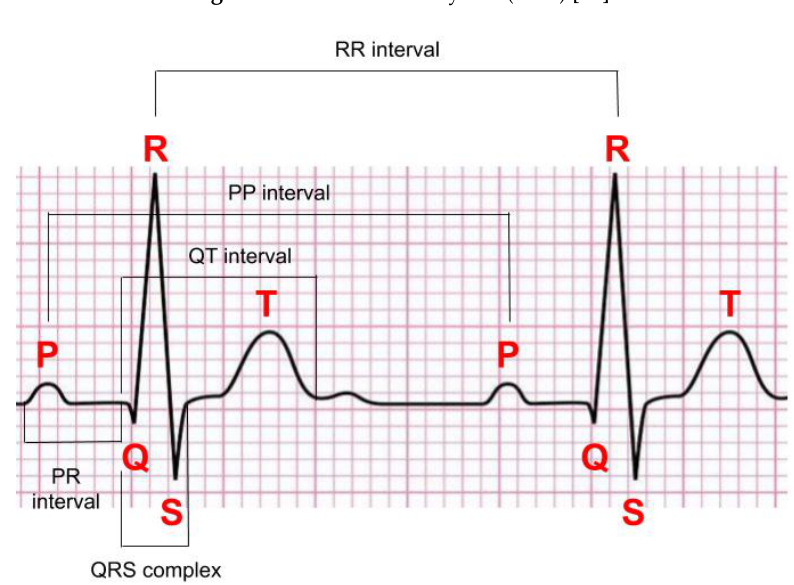
Figure 2. A normal electrocardiogram (ECG) signal and the corresponding notation